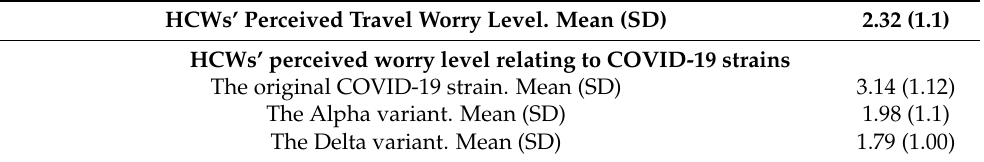
Table 2. Healthcare workers’ (HCWs’) perceived travel worry attributed to COVID-19 and its